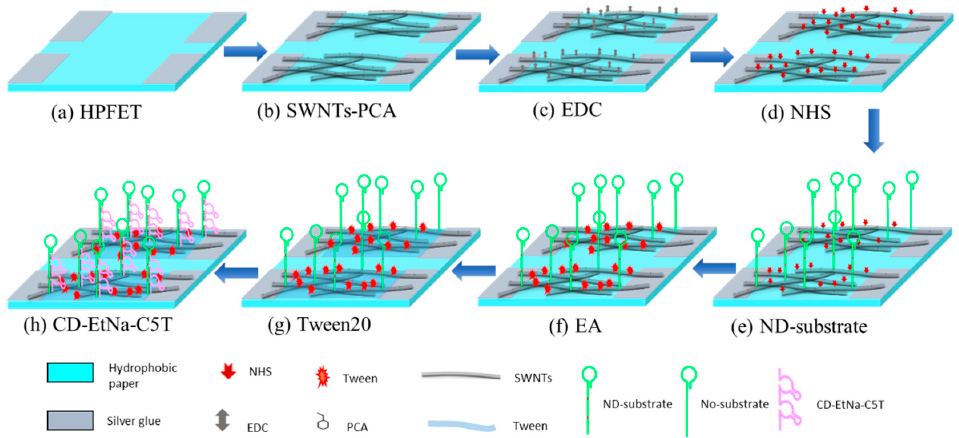
Figure 5. SPFET functionalized with different chemical and biological materials